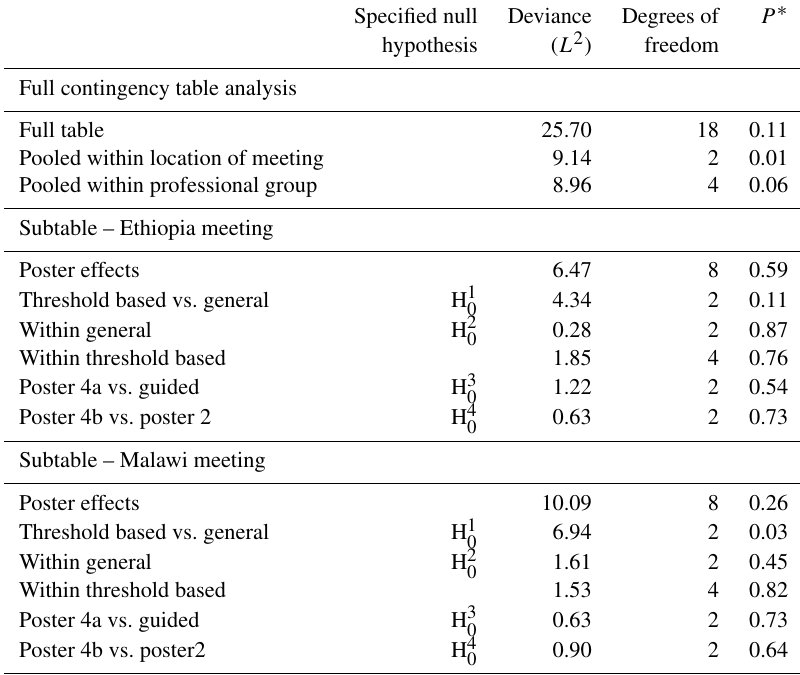
Table 7. Analysis of Q4 according to the location of the meeting, professional group and methods that the latter tested on separate location subtables.